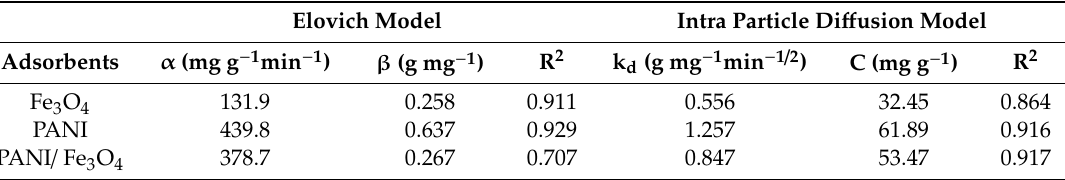
Table 4. Kinetics parameters for adsorption of AB40 on Fe 3 O 4 , PANI and PANI / Fe 3 O 4 composite with Elovich model and intra-particle di ff usion